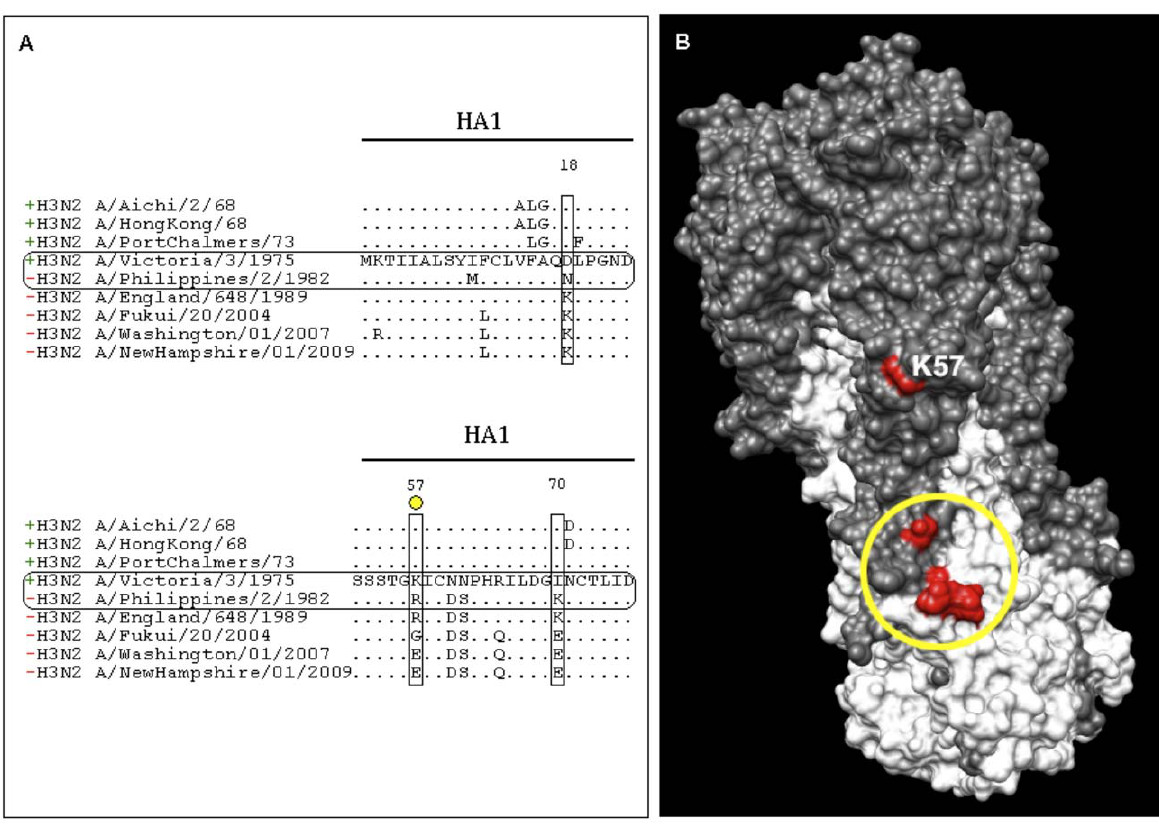
Figure 5. Sequence analysis of H3N2 HA1-hemagglutinins of viral isolates neutralized and not neutralized by PN-SIA28. (A) Aminoacidic sequences of H3N2 strains studied in the paper and in proximity to the region identified on H1N1 hemagglutinin were aligned. Differences among solvent exposed residues close to PN-SIA28 epitope core are boxed. The yellow circle on Lys57Ala mutant indicate 50–75% PN- SIA28 binding compared to wild-type HA. (B) (H3N2) A/Aichi/2/68 hemagglutinin trimer: grey areas indicate the HA1 domains whereas white areas indicate HA2 domains. Red regions indicate the residues able to inhibit PN-SIA28 binding to H3-HA. Yellow circle define the residues involved in the interaction of PN-SIA28 with both, H1 and H3 HAs.